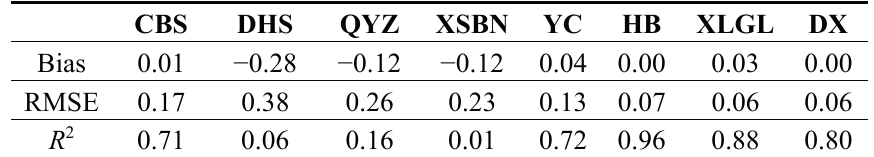
Table 3. Comparison between MODIS-FPAR and GLASS-FPAR. Where, CBS in mixed forests site; DHS and XSBN in evergreen broadleaf forests site; QYZ in evergreen needleleaf forests site; YC in croplands; HB, XLGL and DX in grasslands